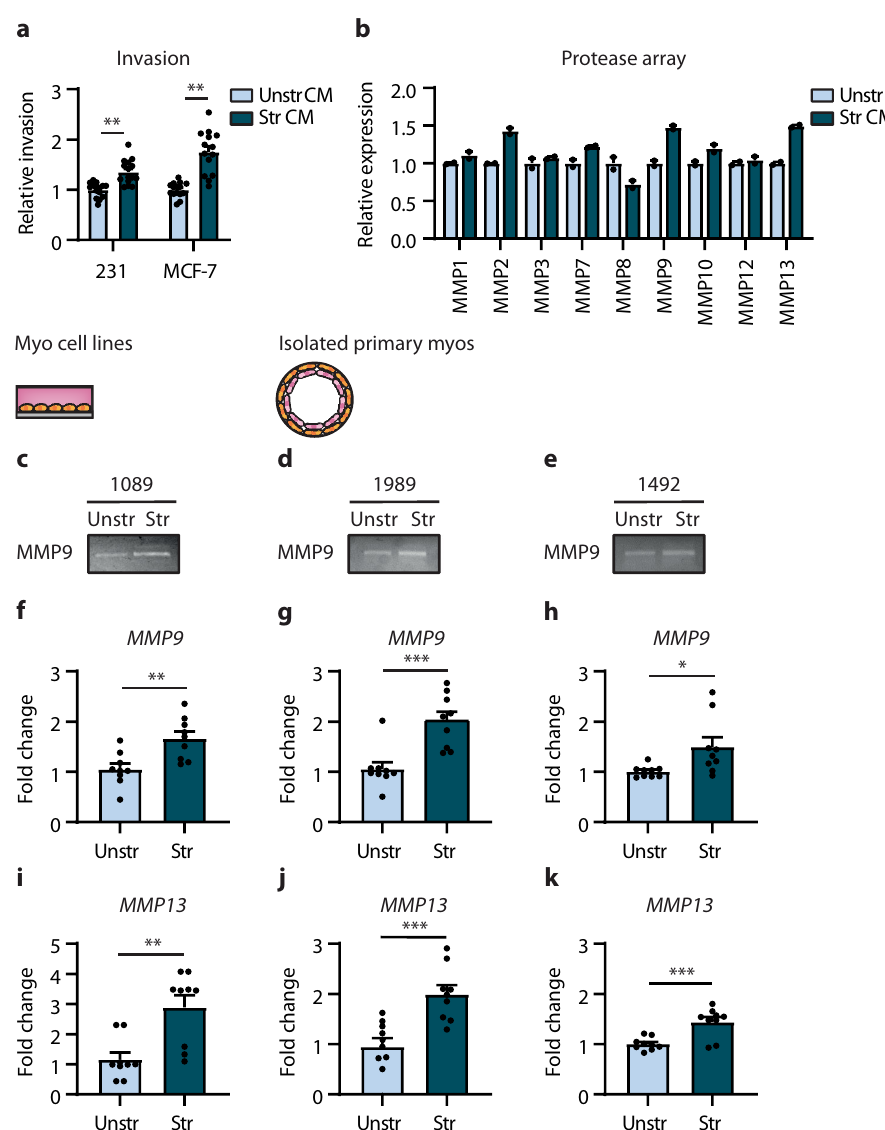
Fig. 6 Mechanical stretching normal myoepithelial cells activates a tumour promoting phenotype. a Invasion assay for MDA-MB-231 (231) and MCF-7 cells using conditioned media (CM) isolated from unstretched (Unstr) or stretched (Str) normal myoepithelial cell line; N-1089 (error bars, + s.e.m). n = 3 biological replicates, 5 technical replicates; **** P < 0.0001 (two-tailed t -test). b Array analysis for proteases using conditioned media isolated from unstretched or stretched myoepithelial cell line; N-1089 (error bars, + s.e.m). n = 1 biological replicate, 2 technical replicates. c – e Gelatin zymography for MMP9 activity using conditioned media isolated from unstretched or stretched myoepithelial cell line; N-1089 ( c ) and primary normal myoepithelial cells; N-1989 ( d ) and N-1492 ( e ). Images are representative of three experiments. f – h Bar graphs showing qRT-PCR analysis for MMP9 using RNA isolated from unstretched or stretched myoepithelial cell line; N-1089 ( f ) and primary normal myoepithelial cells; N-1989 ( g ) and N-1492 ( h ) (error bars, + s.e.m). n = 3 biological replicates, 3 technical replicates; ** P = 0.0035 ( f ), *** P = 0.0005 ( g ) and * P = 0.0232 ( h ) (two-tailed t -test). i – k Bar graphs showing qRT-PCR analysis for MMP13 using RNA isolated from unstretched or stretched myoepithelial cell line; N-1089 ( i ) and primary normal myoepithelial cells; N-1989 ( j ) and N-1492 ( k ) (error bars, + s.e.m). n = 3 biological replicates, 3 technical replicates; ** P = 0.0017 ( i ), *** P = 0.0007 ( j ) and *** P = 0.0009 ( k ) (two-tailed t